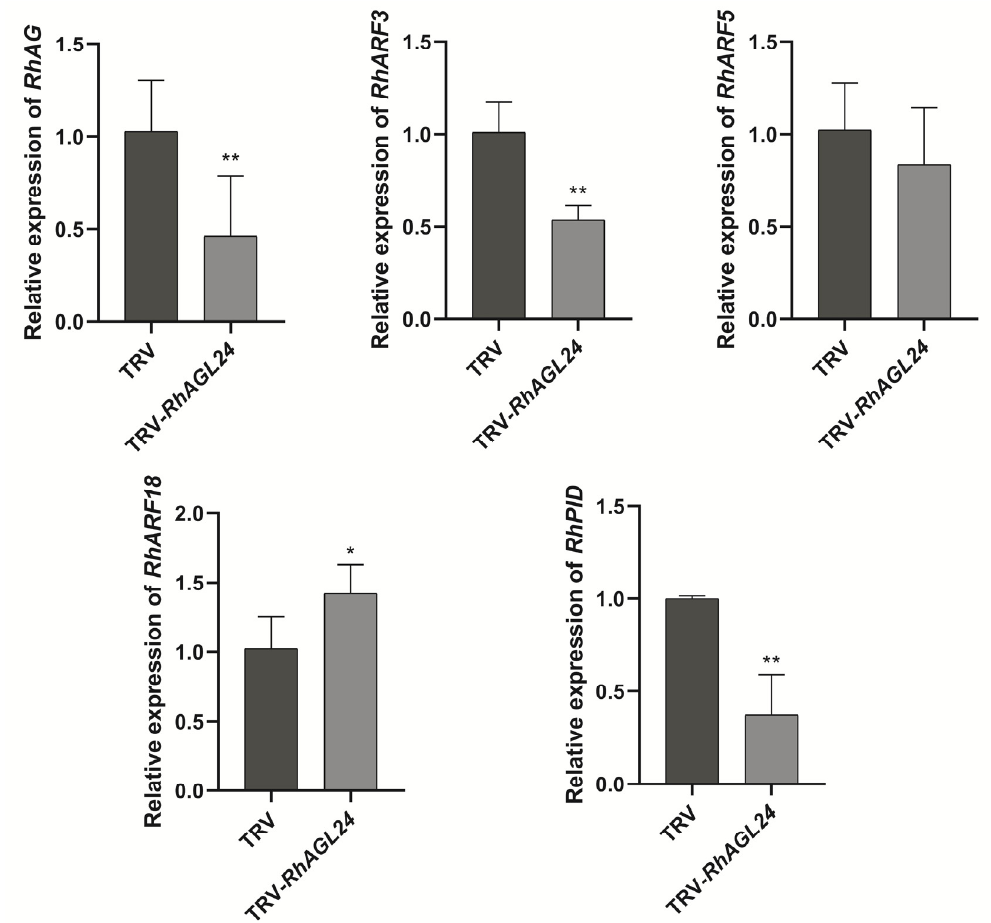
Figure 4. Expression of flower organ identity-related genes in RhAGL24 -silenced plants. All the values are the means ± SD of seven biological replicates. RhUBI2 was used as an internal control. Asterisks indicate statistically significant differences by Student’s t-test (* p < 0.05, ** p < 0.01).